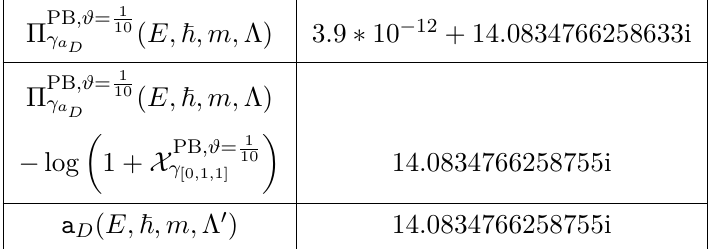
with a . The parameters used D γ aD